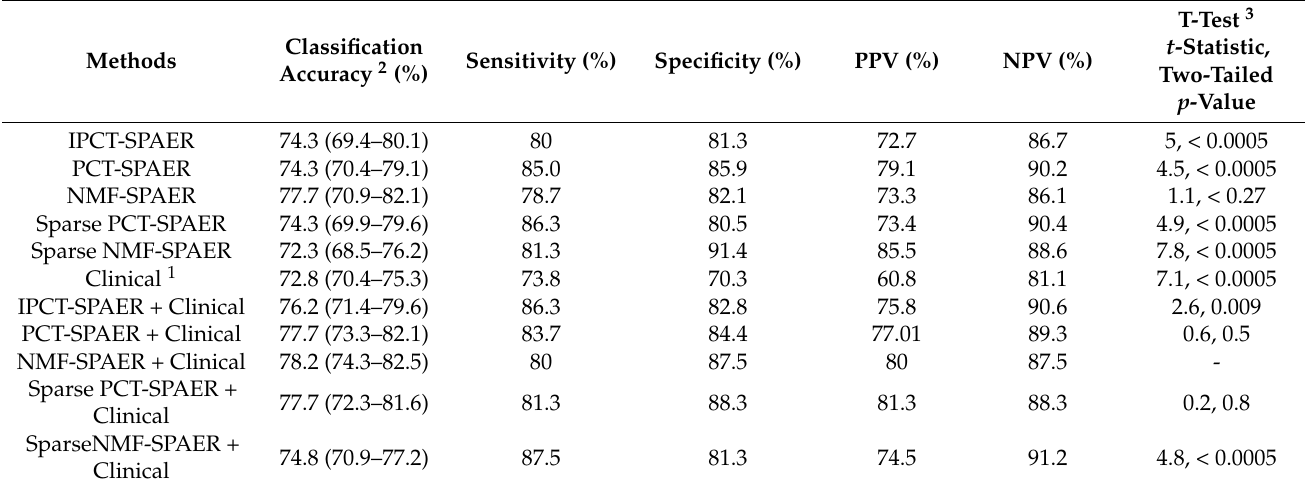
Table 2. Results of diagnosis based on the classification of symptomatic versus asymptomatic patients with leave-one-out